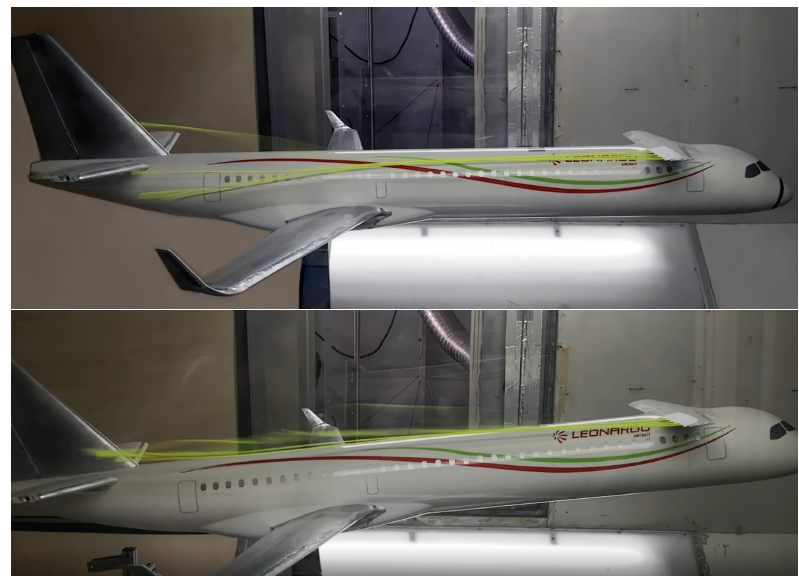
Figure 14. Canard wake impingement on the horizontal tailplane: visualization test through wool yarns. V = 35m/s, Re = 315,000 at α = 4° and 8°.